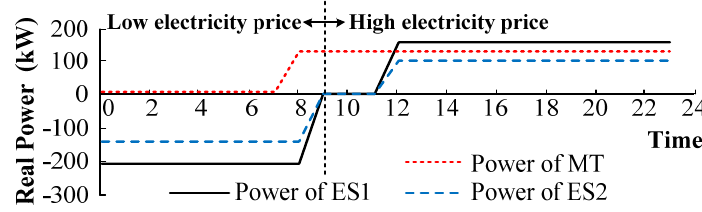
Figure 10. Operations of ES1, ES2 and MT without optimization.